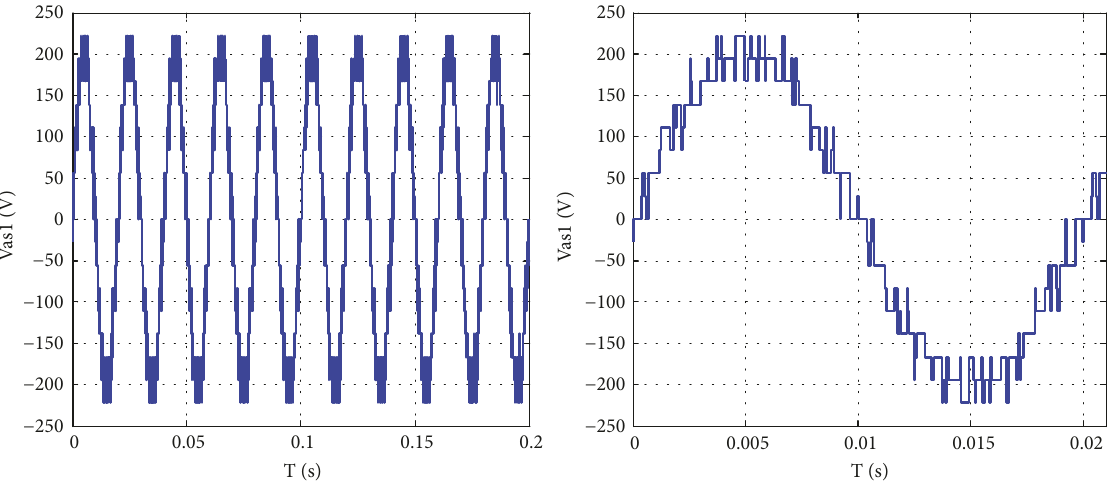
Figure 6: Waveform of output voltage 𝑉 𝑎𝑠1 for m=7.